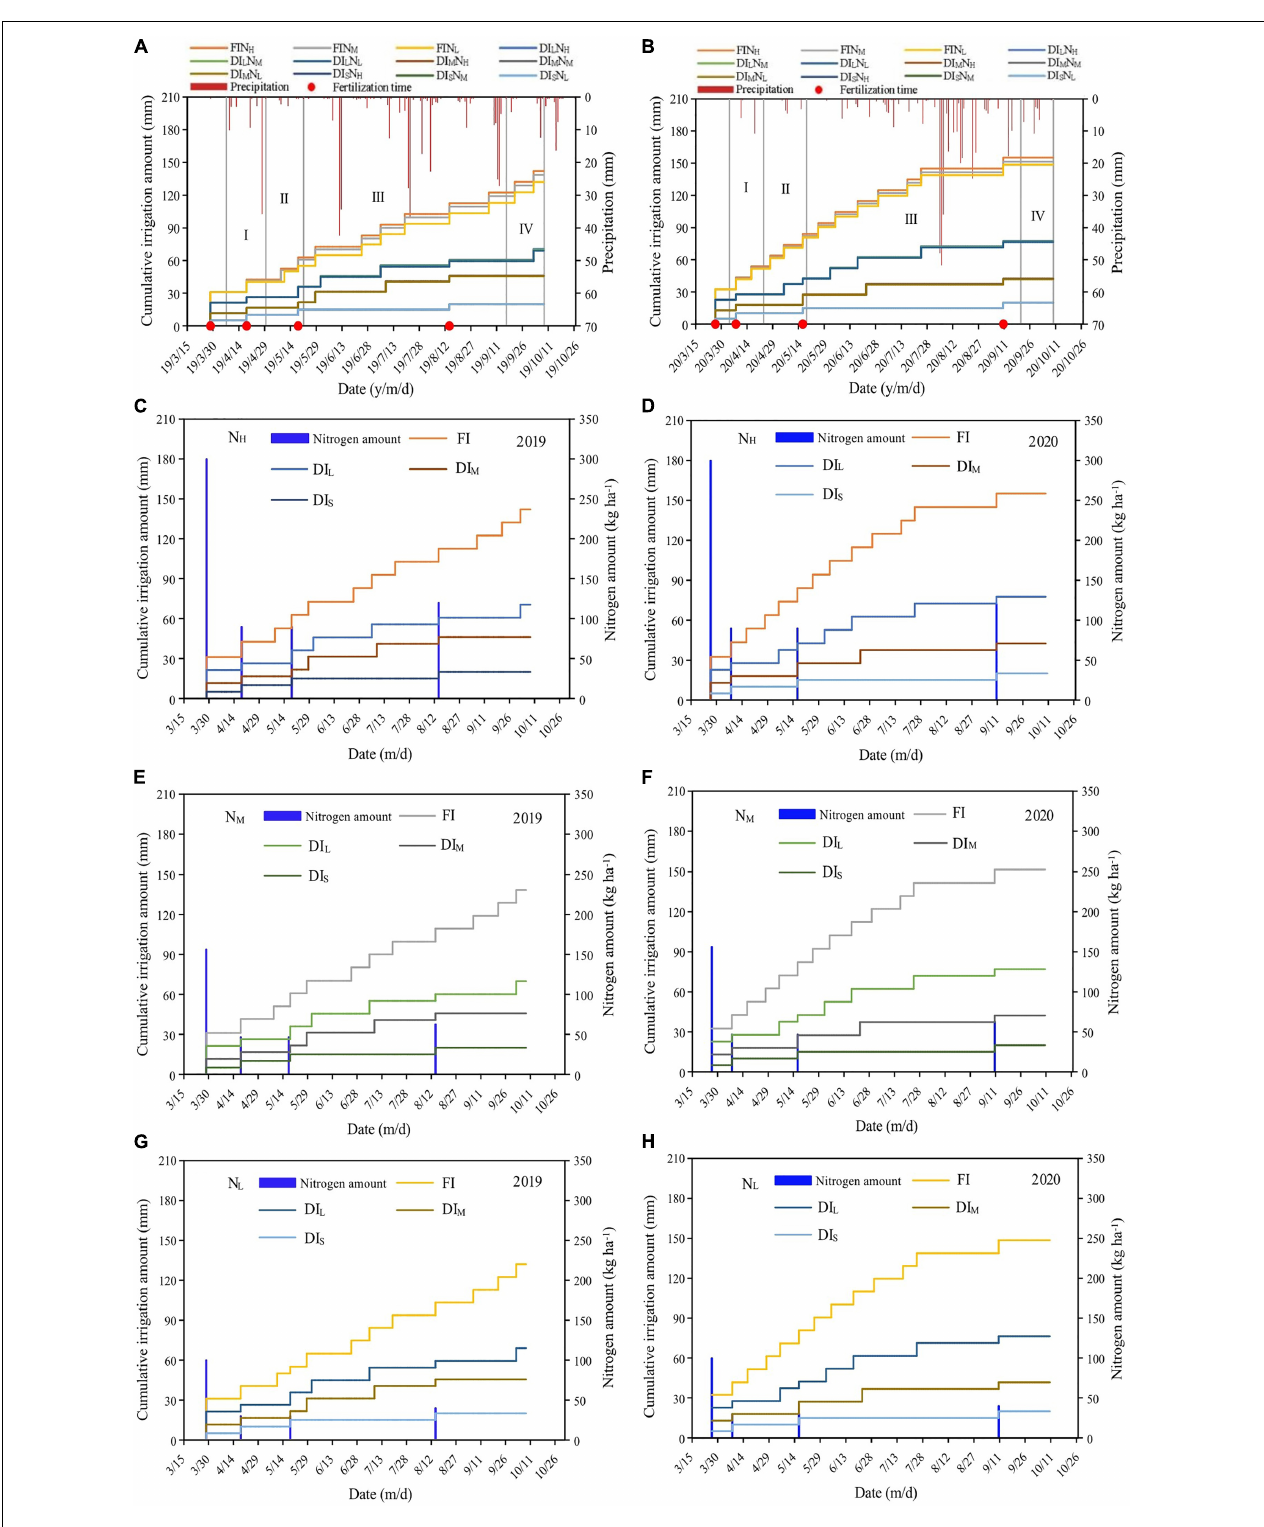
FIGURE 2 | Precipitation, timing, and amounts of irrigation, and nitrogen fertilizer applied each time for apples in 2019 (A,C,E,G) and 2020 (B,D,F,H) . I, II, III, and IV are the sprout leaves stage, flowering and fruit-setting stage, fruit expansion stage, and fruit maturity stage, respectively. FI, DI L , DI M , and DI S are full irrigation, light deficit irrigation, moderate deficit irrigation, and severe deficit irrigation, respectively. N H , N M , and N L are high nitrogen, medium nitrogen, and low nitrogen, respectively.